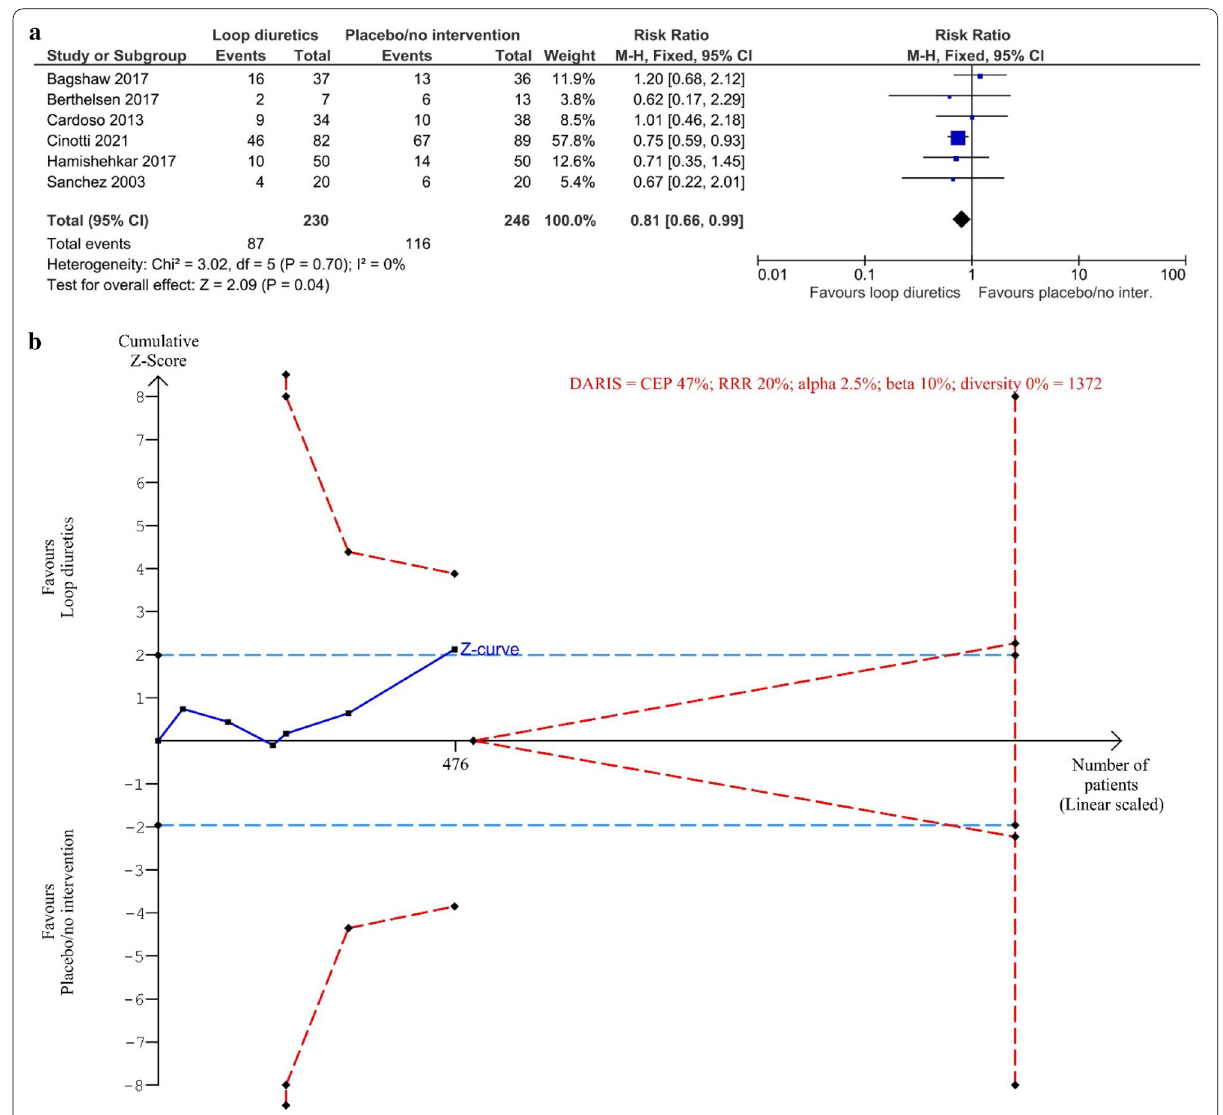
Fig. 3 Meta-analysis and TSA on highest event rate of SAEs for loop diuretics vs. placebo/no intervention. a Meta-analysis. b TSA. The diversity adjusted required information size (DARIS) was calculated according to the proportion of SAEs in the control group (CEP) of 47%; risk ratio reduction (RRR) of 20% in the experimental intervention group; alpha of 1.7%; a beta of 10% (90% power); and diversity 0%. The DARIS was 1372 participants. The cumulative Z-curve (blue line) did not cross the trial sequential boundaries for benefit or harm or the inner-wedge futility line (red outward sloping red lines) nor the DARIS. The light blue dotted lines show naïve conventional boundaries (alpha